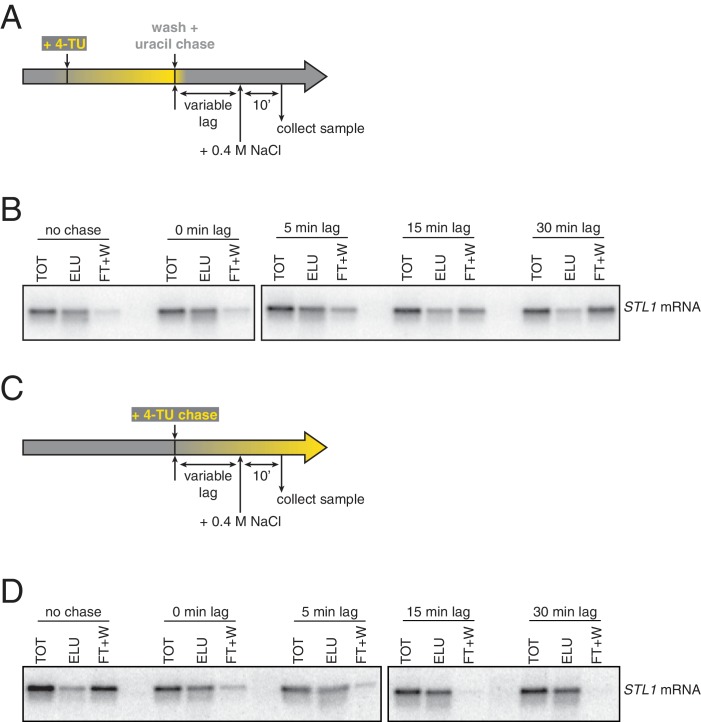
Analysis of chase efficiencies as a function of lag time and labeling scheme.(A) 4TU-pulse/uracil-chase labeling scheme and experimental setup for (B). (B) Wild-type cells (KWY165) were grown to exponential phase, the experiment outlined in (A) was performed and levels of STL1 mRNA were determined by northern blot. (C) 4TU-chase labeling scheme and experimental setup for (D). (D) Wild-type cells (KWY165) were grown to exponential phase, the experiment outlined in (C) was performed and levels of STL1 mRNA were determined by northern blot.